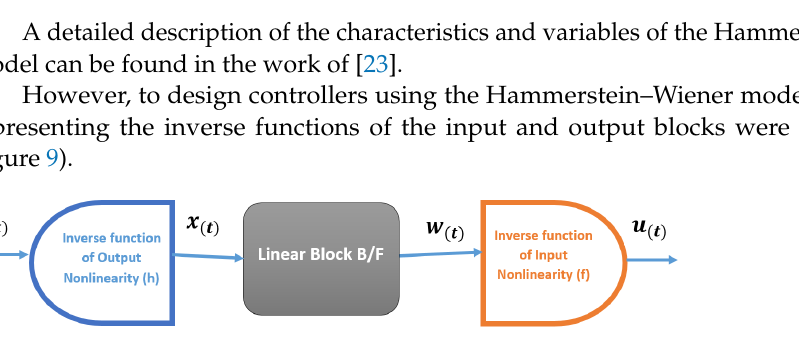
Figure 9. Block diagram of the Hammerstein–Wiener model with inverse